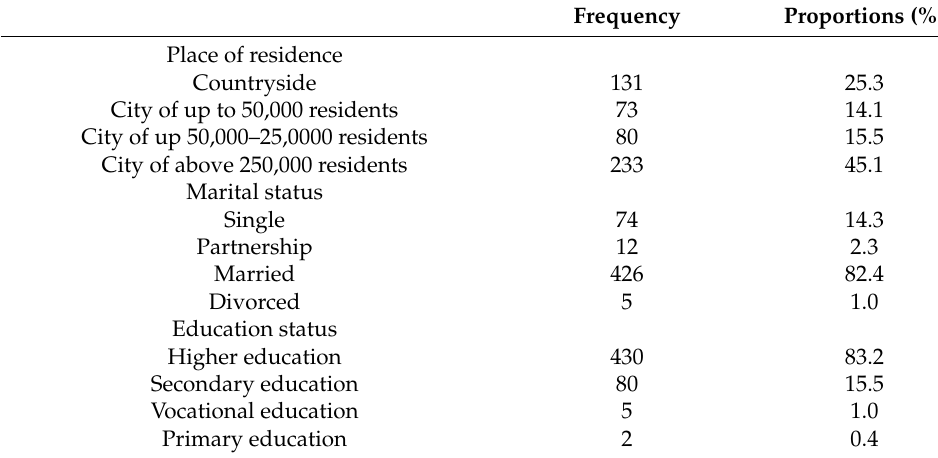
Table 1. Characteristics of the research group.